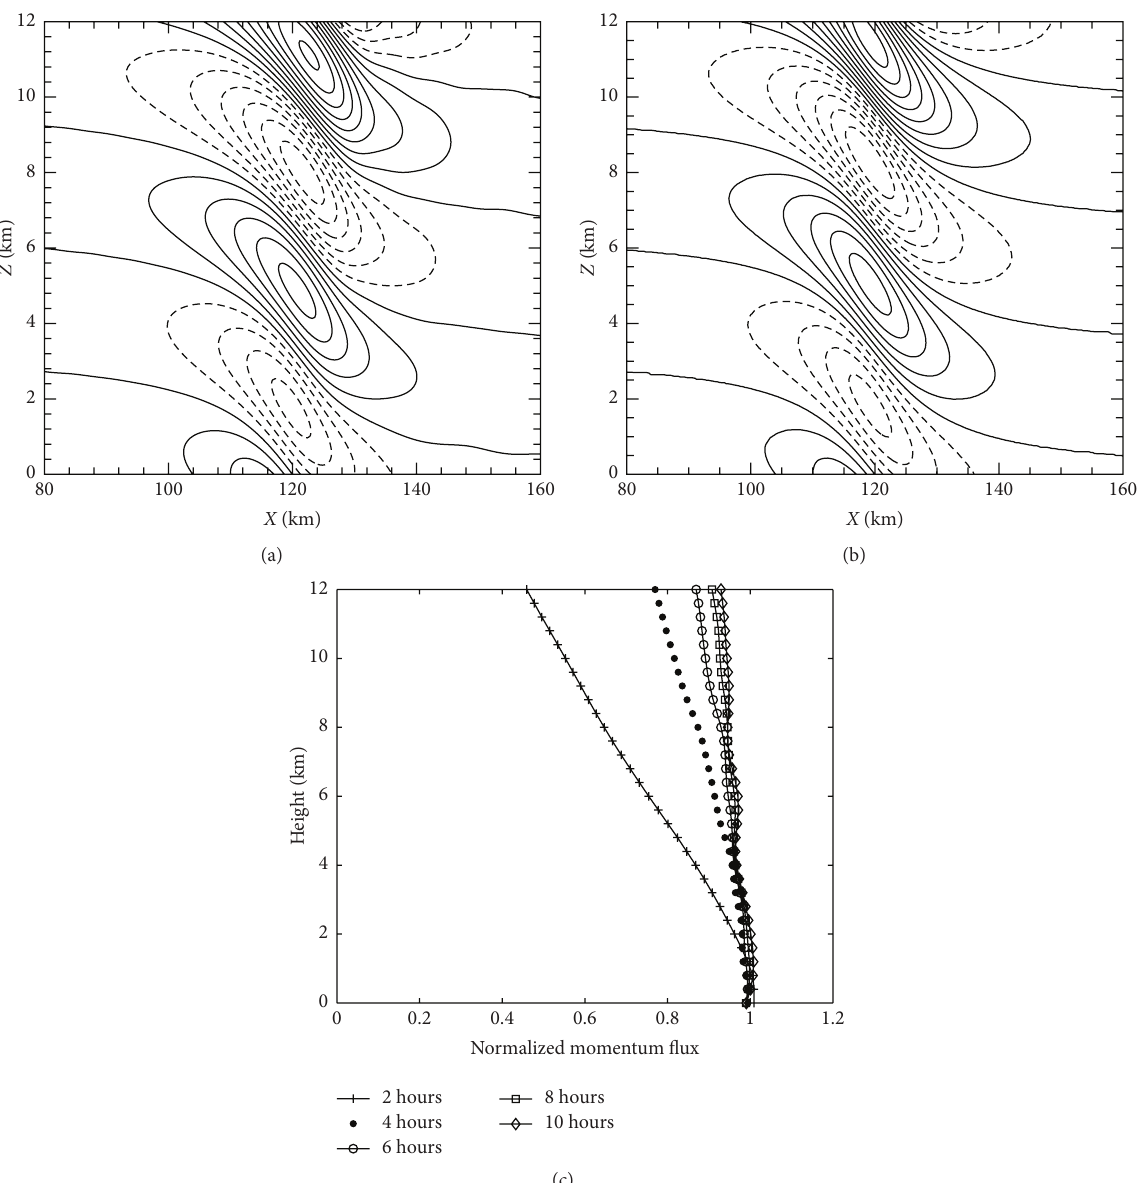
Figure 1: Numerical results of linear hydrostatic mountain waves. Numerical solution (a), semianalytical solution (b), and normalized momentum flux (c) are shown. The contour values vary from − 0.005 to 0.005 with an interval of 0.0005. Negative values are denoted by dashed